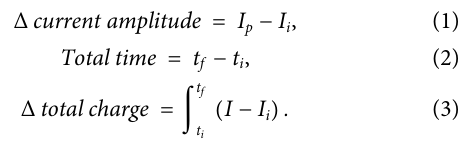
Frontiers in Chemistry |